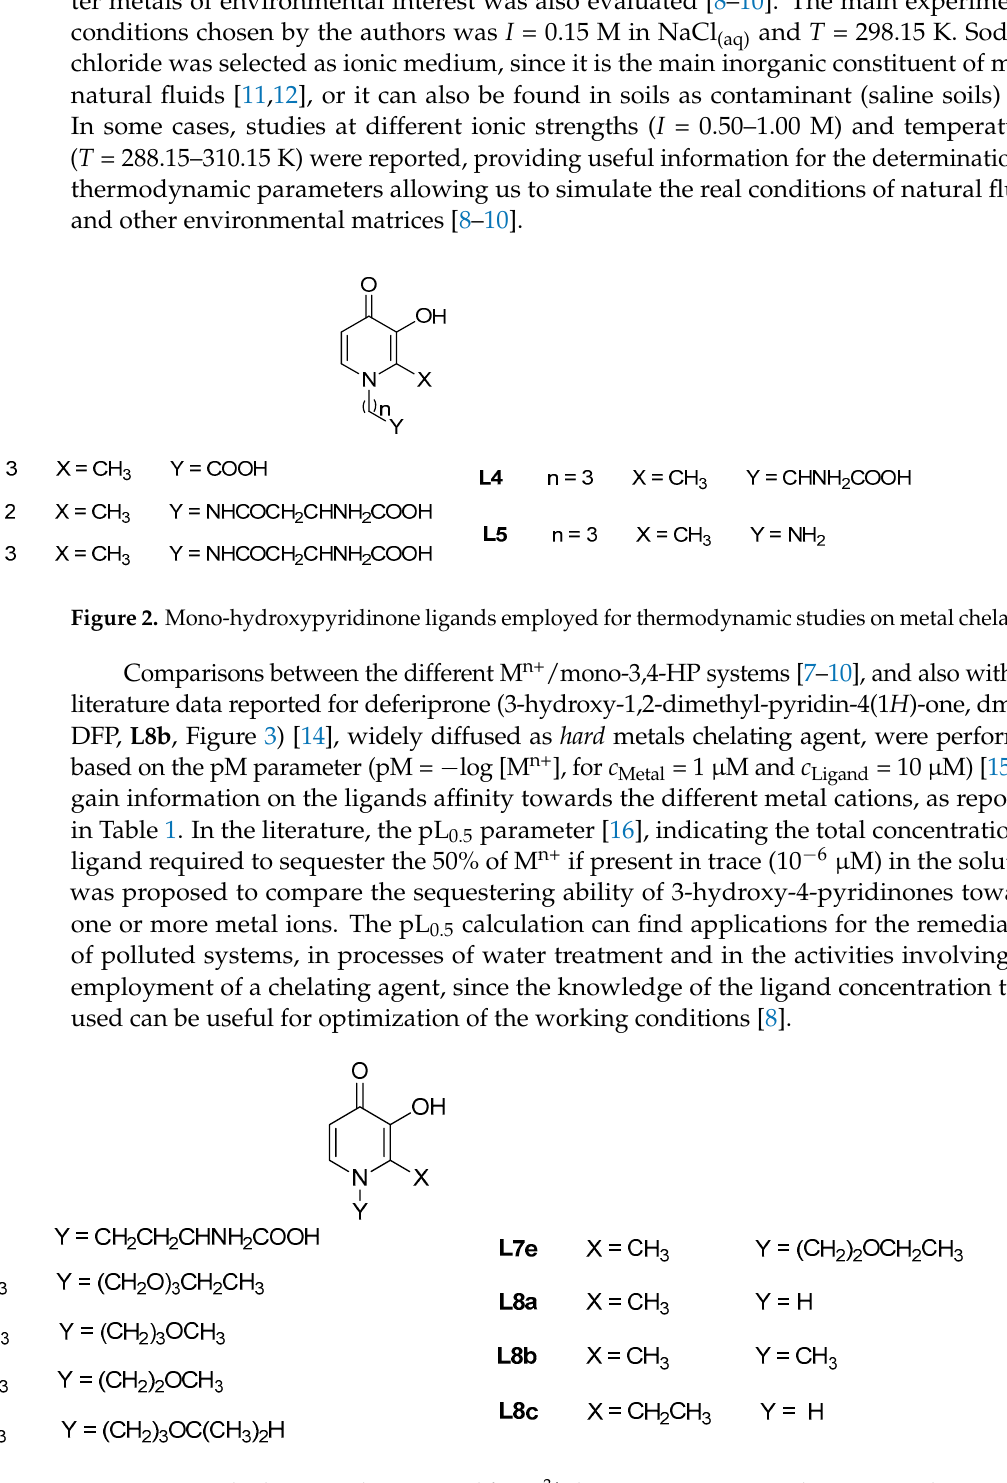
Figure 3. Mono-hydroxypyridinones used for Fe 3+ determination in natural matrices and as potential new fertilizers. Table 2. LOD and LOQ values determined using hydroxypyridinone ligands for Fe 3+ assay.